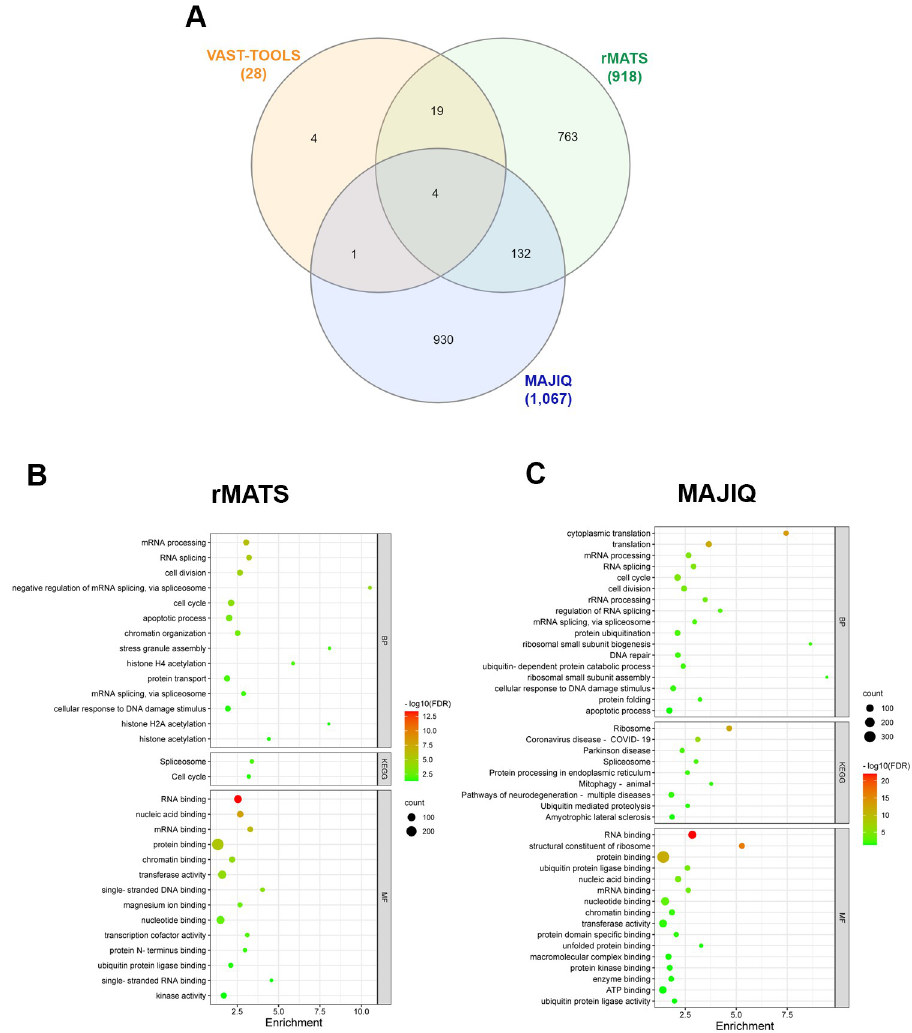
Fig 6. Analysis of alternative splicing events predicted to be altered by ethanol in the mouse gastrula dataset. A) Venn diagram showing the number of genes predicted to undergo alternative splicing events altered by ethanol using VAST-TOOLS, rMATS, and MAJIQ. B, C) Gene Ontology analysis of genes predicted by rMATS (B) and MAJIQ (C) to undergo alternative splicing events altered by ethanol. BP, Biological Process, MF, Molecular Function, KEGG, Kyoto Encyclopedia of Genes and Genomes, FDR, False Discovery